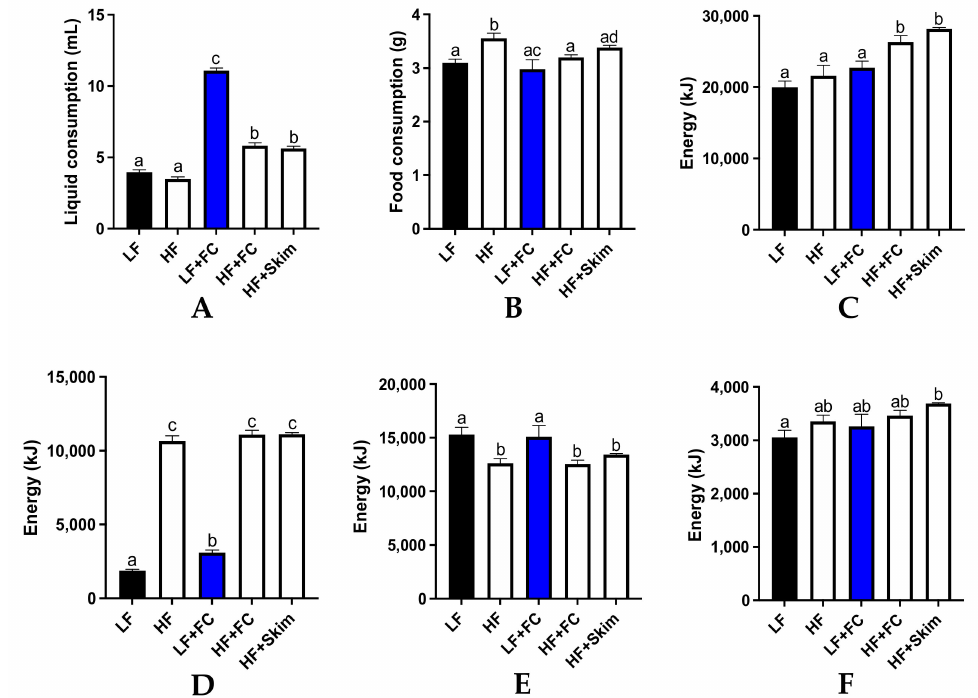
Figure 1. Liquid consumption ( A ) and food consumption ( B ) was measured daily per mouse over the 13-week interventions. Total energy consumption ( C ), total energy from lipids ( D ), total energy from carbohydrates ( E ) and total energy from protein ( F ) was also measured following 13-week interventions. Energy consumptions are cumulative following the 13-week intervention. Groups with unlike letters were significantly different ( p <